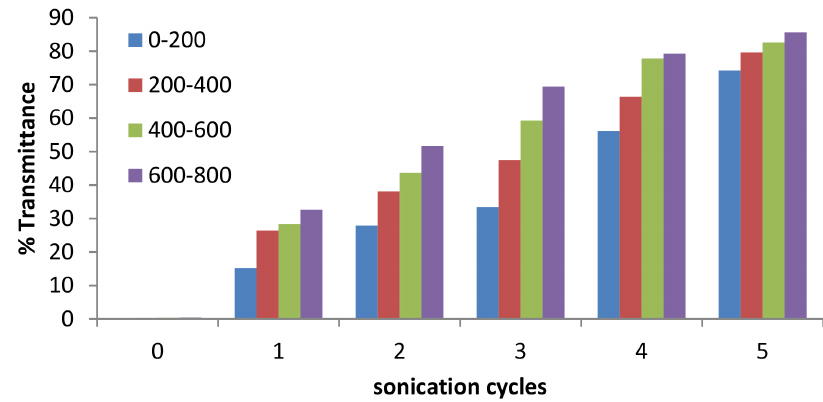
FIGURE 3 - Nanosizing charaterization by UV spectroscopic method.